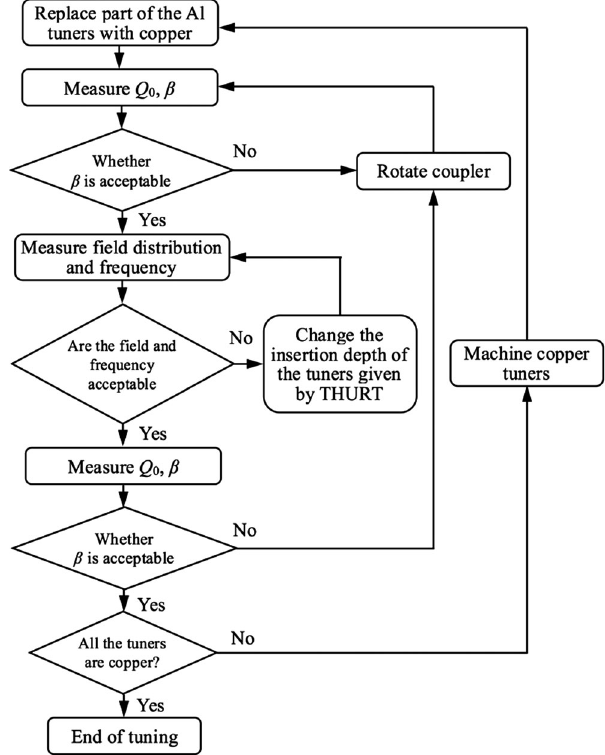
FIG. 14. Flow chart of the field tuning of the XiPAF RFQ.